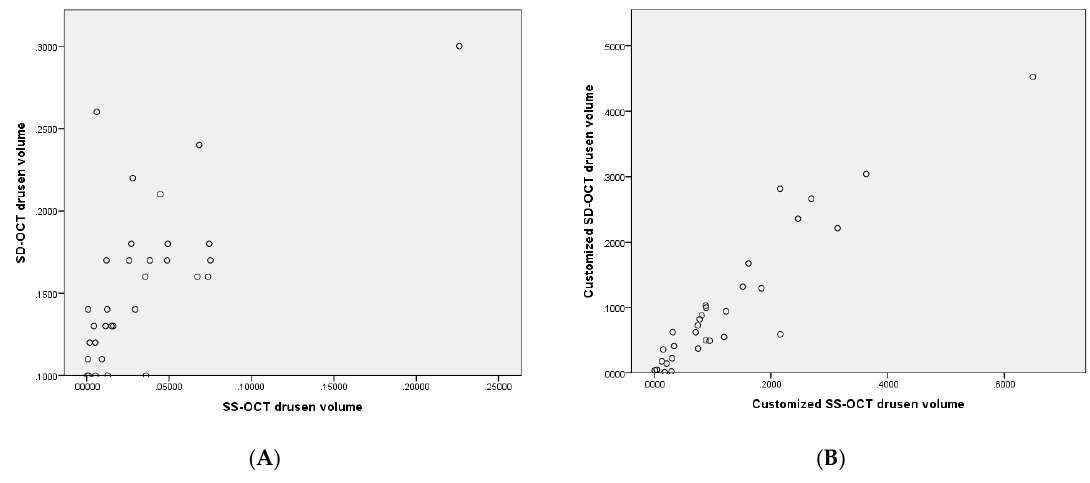
Figure 4. ( A ) Scatter plot illustrating 1 and 3 mm ETDRS circle drusen volume assessed by machine inbuilt algorithm of Heidelberg Spectralis SD-OCT after manual correction ( Y -axis) vs. the Zeiss SS-OCT assessed and manually corrected 3 mm ETDRS circle drusen volume ( X -axis). ( B ) Scatter plot illustrating 1 and 3 mm ETDRS circle drusen volume of Heidelberg Spectralis SD-OCT assessed by customized software ( Y -axis) vs. respective drusen volume of Zeiss SS-OCT assessed by customized software ( X -axis).